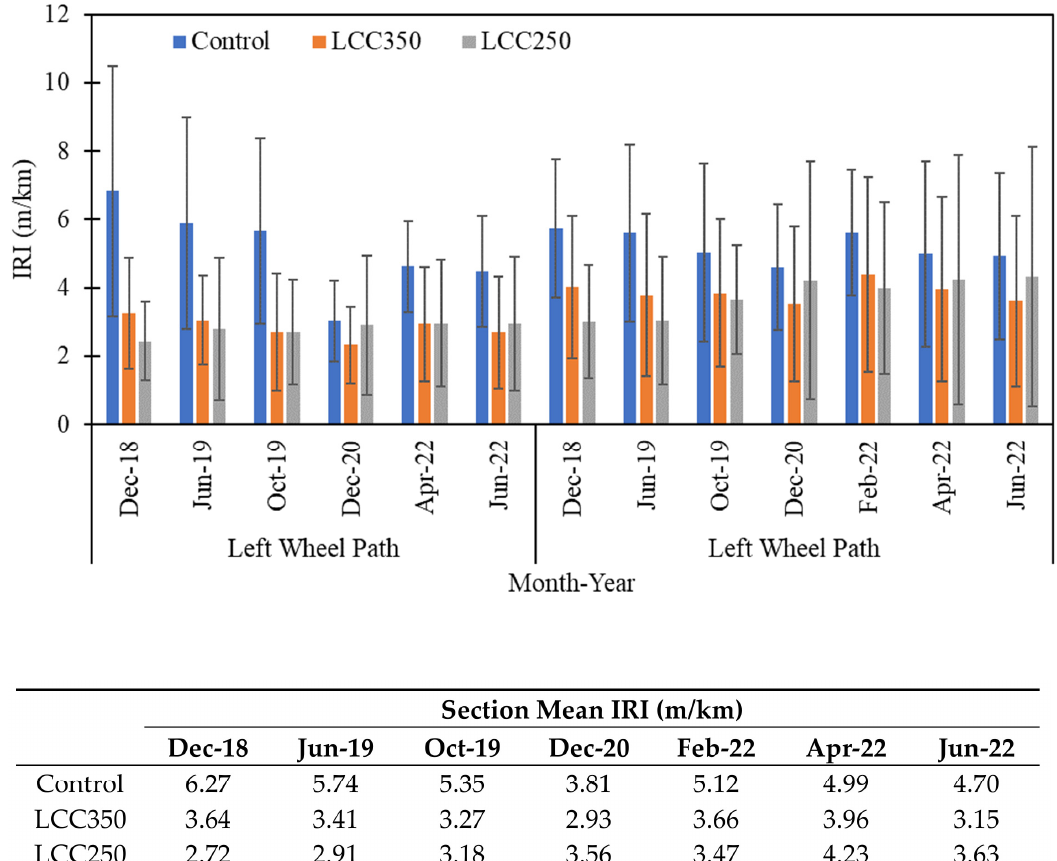
Figure 11. Erbsville measured IRI.